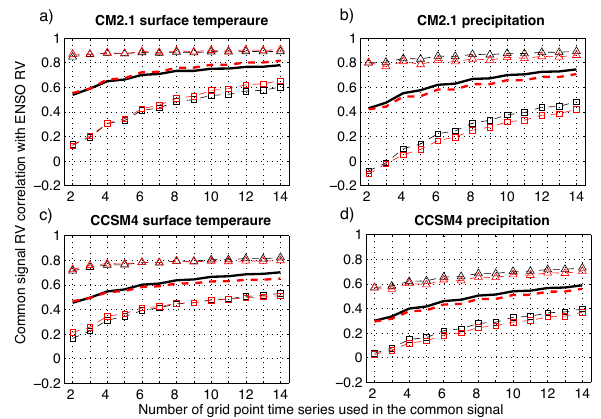
Figure 4: a) the 5% (dashed line with squares), 50% (solid line) and 95% (dashed lines with triangles) of the correlation coefficients calculated between the CM2.1 simulated MRV T S and ENSO running variance are displayed in red, while those of the CM2.1 simulated RVM T S and ENSO running variance are displayed in black. b) as in a) but for the CM2.1 precipitation data. c) and d) as in a) and b) but for CCSM4 T S and precipitation data respectively. The x-axis in each panel displays the number of grid point time series used to calculate the common signal.